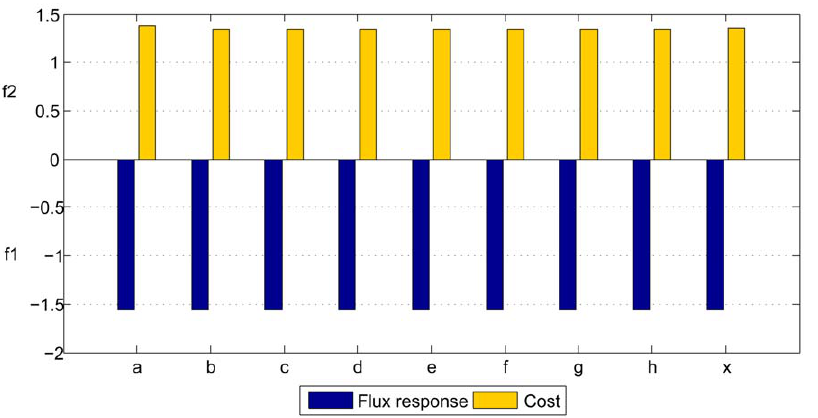
Figure 7. Evaluation with knee parameters and consensus parameters. Values of flux response ( f 1 ) and cost ( f 2 ) for course f evaluated with the sets of parameters corresponding to the knees obtained for the different courses and with the consensus set of parameters, represented as x.